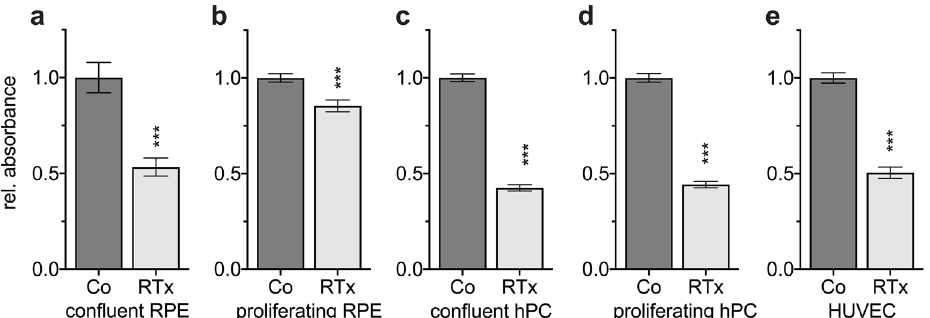
Figure 3. Irradiation inhibits cell proliferation of RPE cells, hPC and HUVEC. Human RPE, hPC and HUVEC cultured under permissive or non-permissive conditions were irradiated with 16 Gy. BrdU proliferation assay was performed 7 d after treatment and plotted as relative fold change to the untreated control group. ***p < 0.001; n = 48 of three independent experiments. Co: untreated control group; RTx: irradiated group; Figure was created using Graph Pad Prism 8 (Version 8.4.3.; www. graph pad.